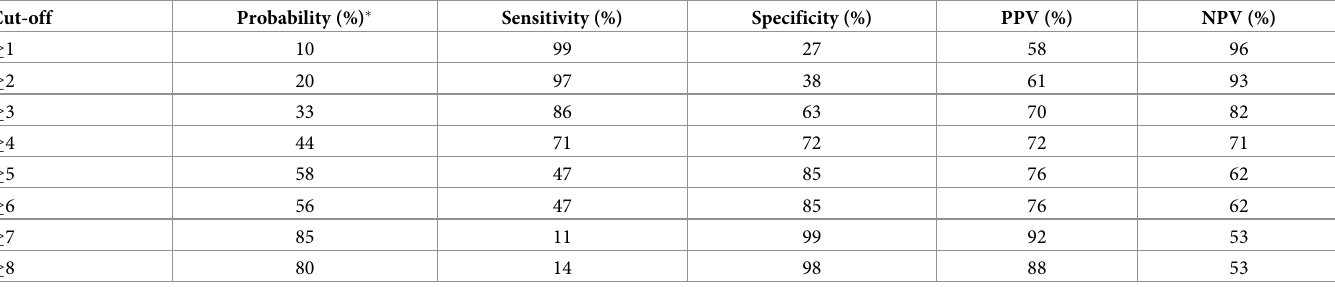
Risk scores were calculated in each patient in the derivation cohort.